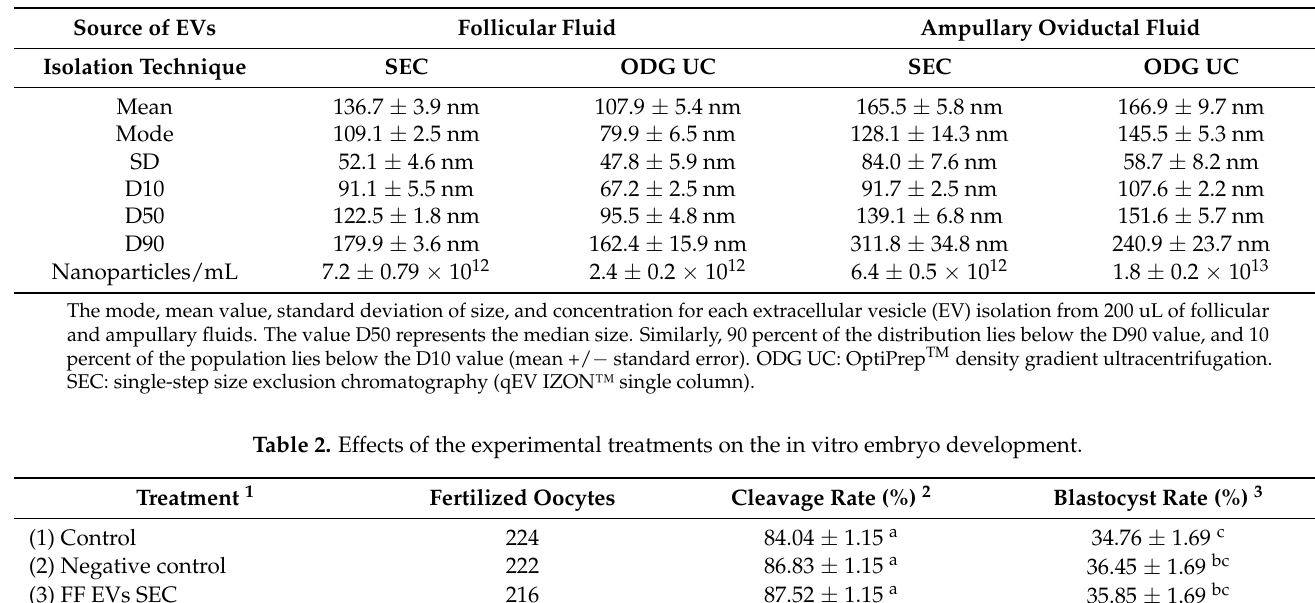
Table 1. Comparison of extracellular vesicle isolation methods by nanoparticle analysis.